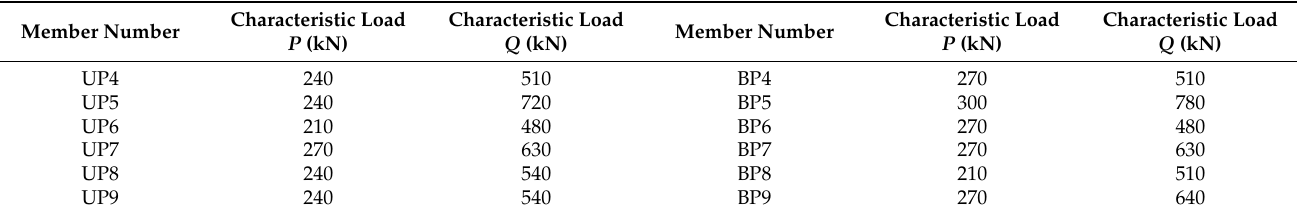
Table 5. Characteristic loads of test beams.